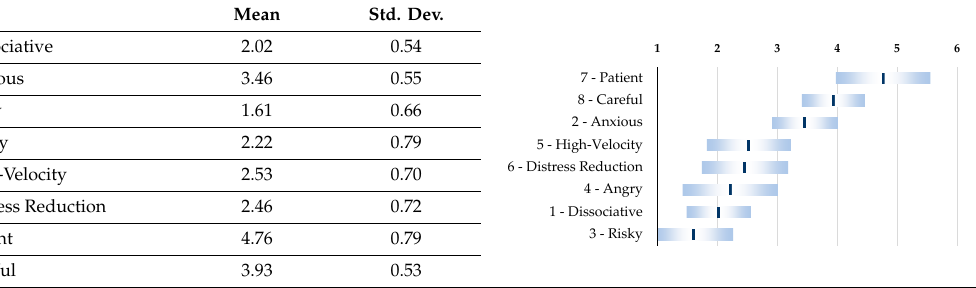
Table 5. Self-assessment of driving style (the factors have been ranked by value in the graphics). Factor Mean Std. Dev.